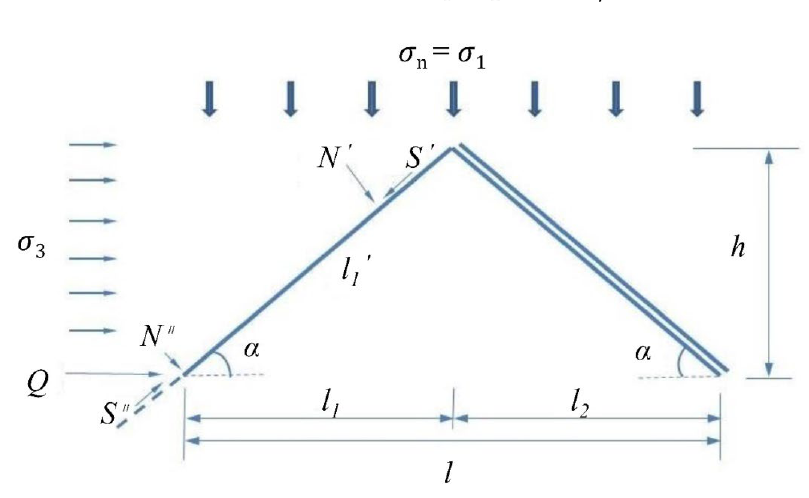
Figure 10. Shear mechanical model of the sawtooth joint.